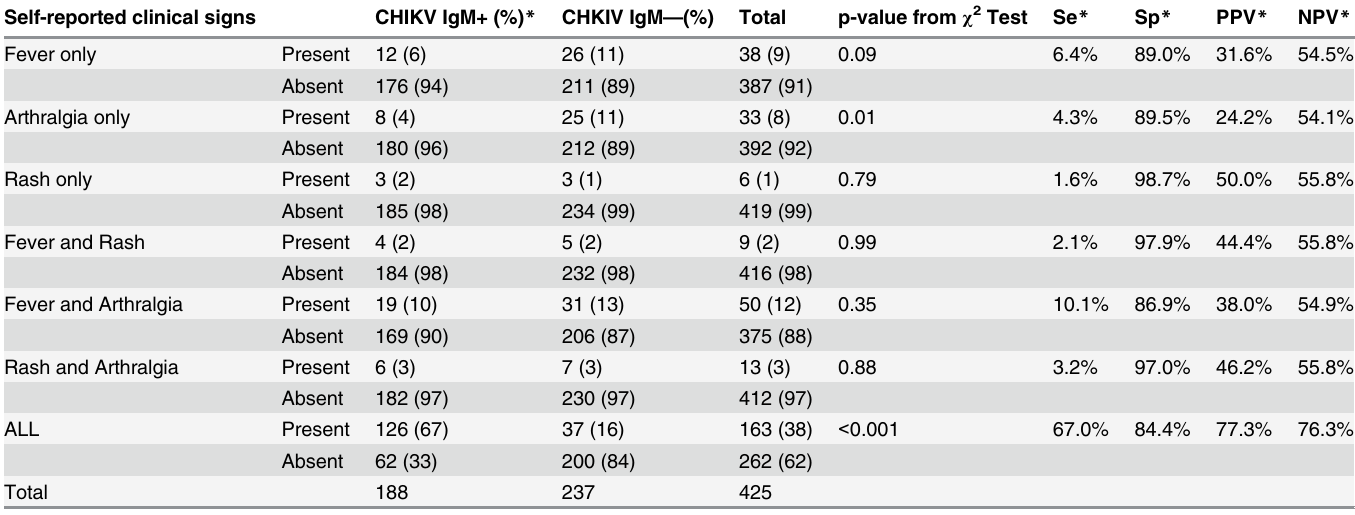
Table 1. Self-reported clinical signs of CHIKV E1-A226V infection, and their diagnostic sensitivity/specificity and predictive values, Trapeang Roka, 2012. Self-reported clinical